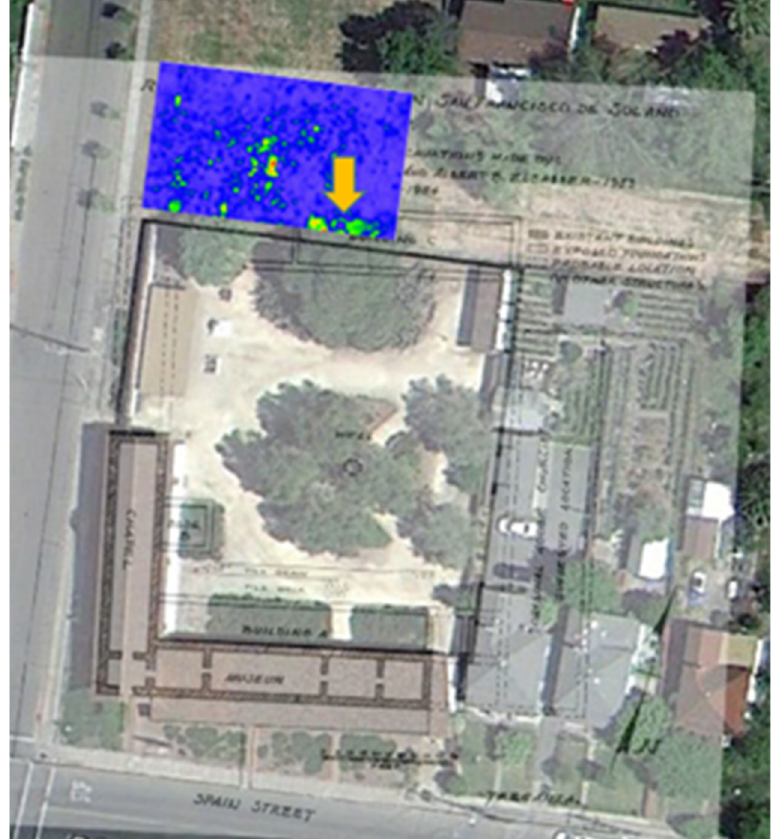
Figure 21. Mission Sonoma GPR survey superimposed on previously excavated units and hypoth- esized extension of features [8], Figure 9.